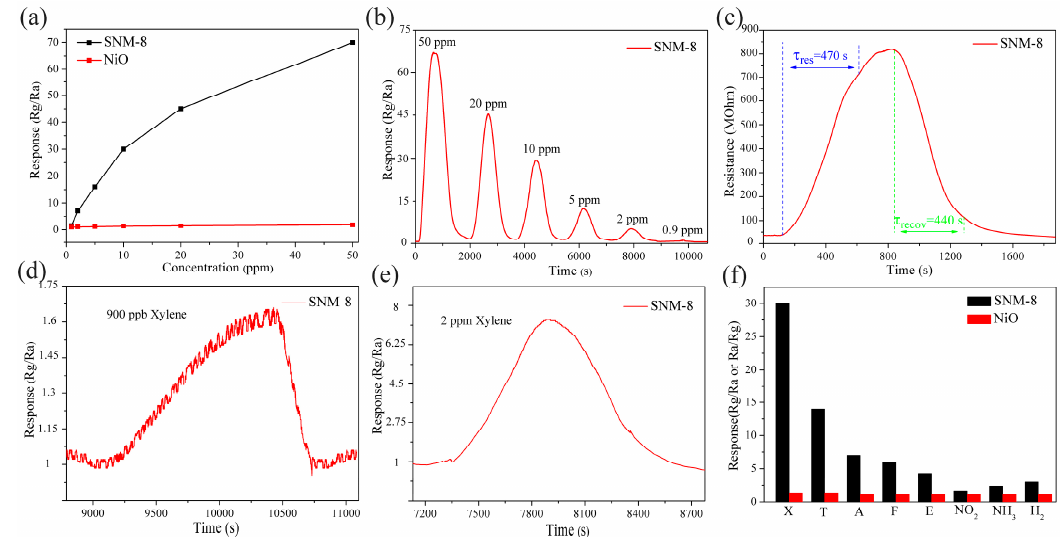
Figure 8. ( a ) Responses of the NiO and SNM-8 sensors as a function of the xylene concentration at 180 ° C; ( b ) Dynamic response of the SNM-8 sensor to 0.9-50 ppm xylene at 180 ° C; ( c ) Response and recovery times of the SNM-8 sensor to 10 ppm xylene at 180 °C; ( d , e ) Response curve of the SNM-8 sensor to 900 ppb and 2 ppm xylene at 180 ° C, respectively; ( f ) Gas responses of the SNM-8 sensor to 10 ppm of various VOCs (X, xylene; T, toluene; A, acetone; F, formaldehyde; E, ethanol), 10 ppm NO 2 , 100 ppm NH 3 , and 100 ppm H 2 at 180 °C.